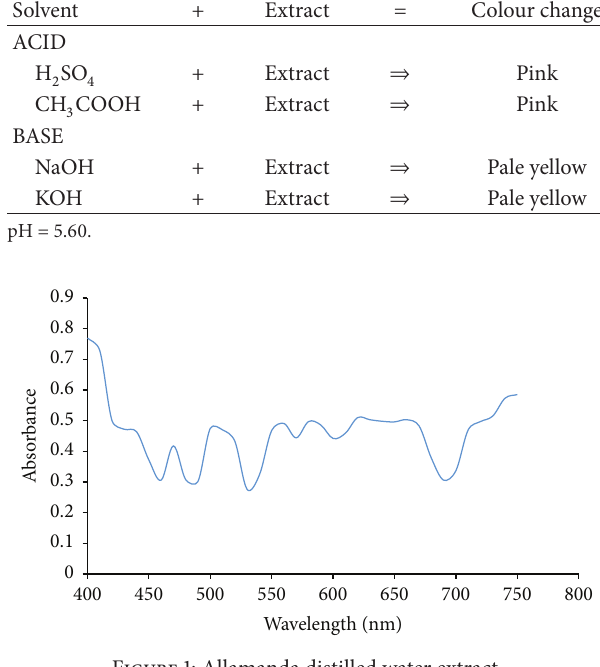
Figure 1: Allamanda distilled water extract.